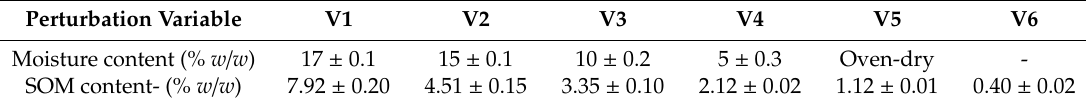
Table 1. Outlines the two different types of perturbations that have been utilised for applying the synchronous two-dimensional correlation spectroscopy (2D-COS) analysis in this work.